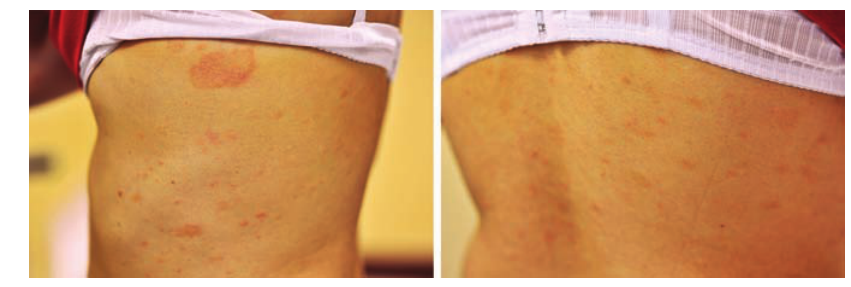
Figure 2. Typical lesions of pityriasis rosea on the trunk of a woman with pityriasis